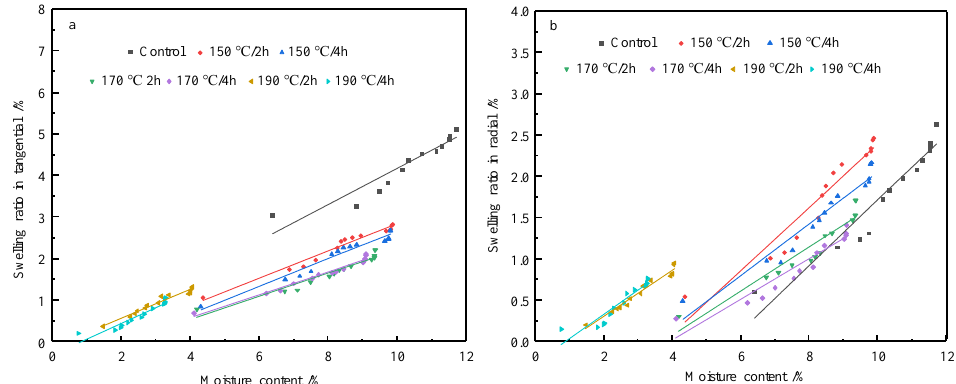
Figure 6. Relation between welling ratio and moisture content of control and HT wood in tangential ( a ) and radial ( b ) direction. ( a ) and radial ( b )